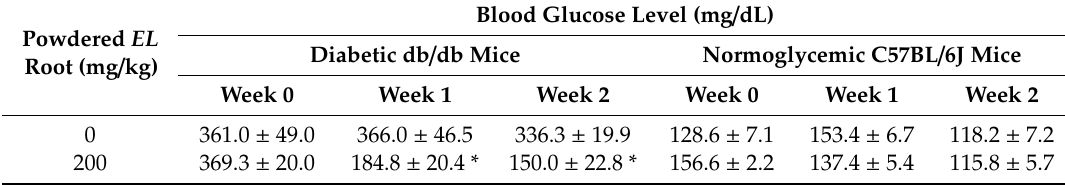
Table A1. The anti-hyperglycemia activity of powdered E. longifolia root in diabetic db / db mice and normoglycemic C57BL / 6J mice (pilot study).